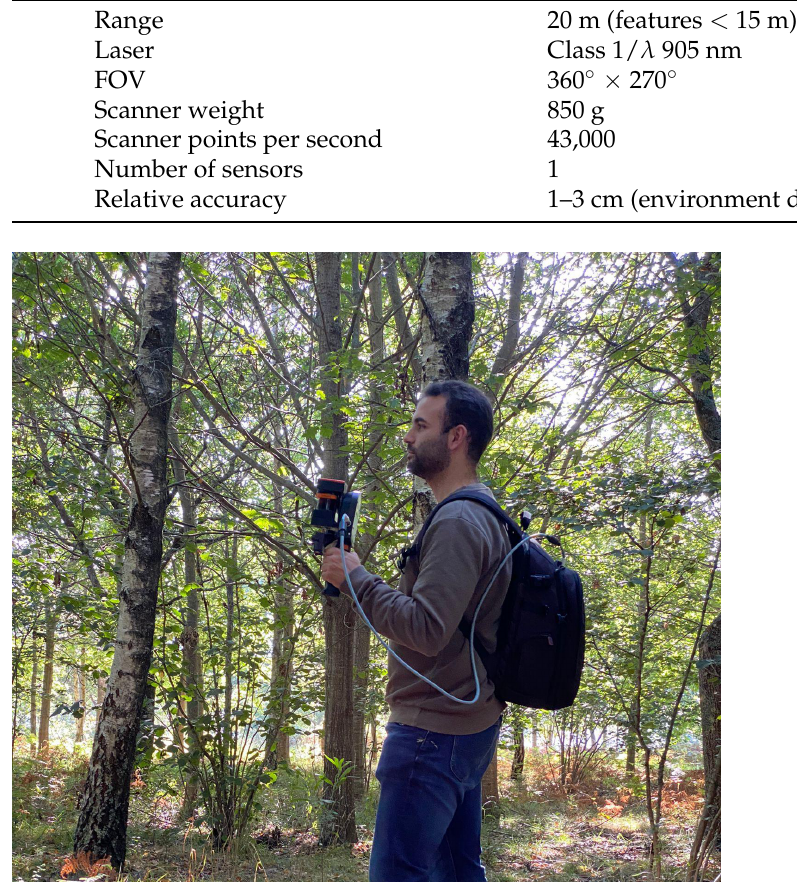
Figure 1. Backpack LiDAR system used during the data acquisition in the study